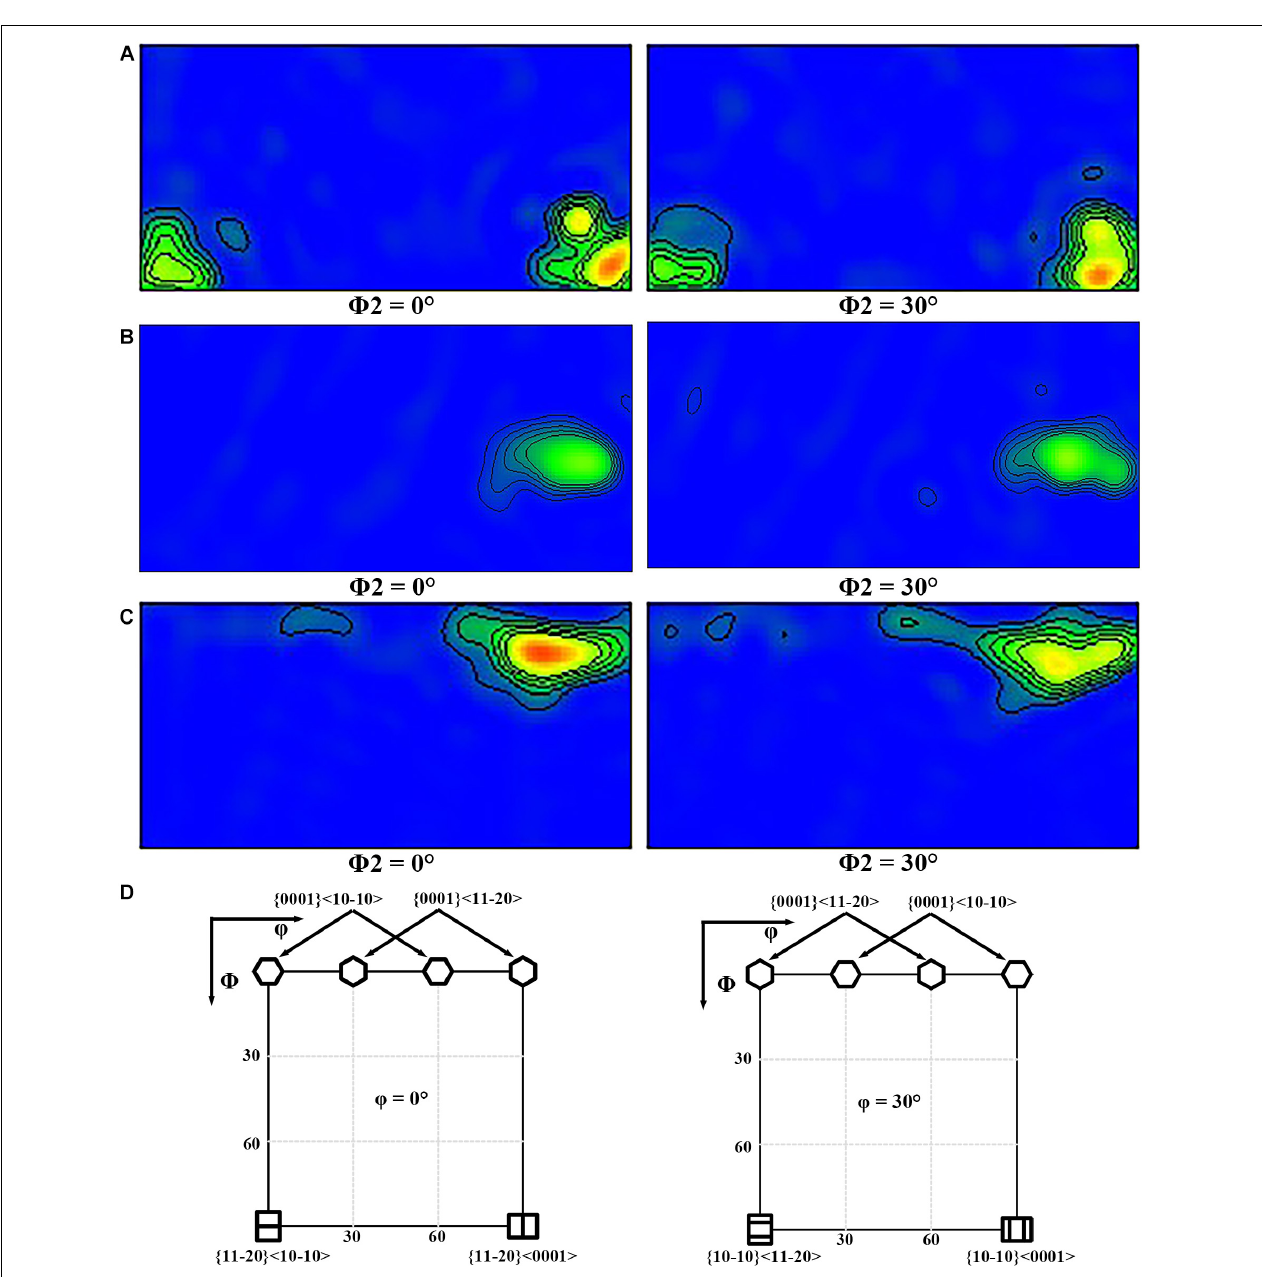
FIGURE 6 | The ODF map of {0001} plane: (A) BM, (B) FSP, (C) FSP-ZrO2; (D) the standard ODF map of hcp structure.